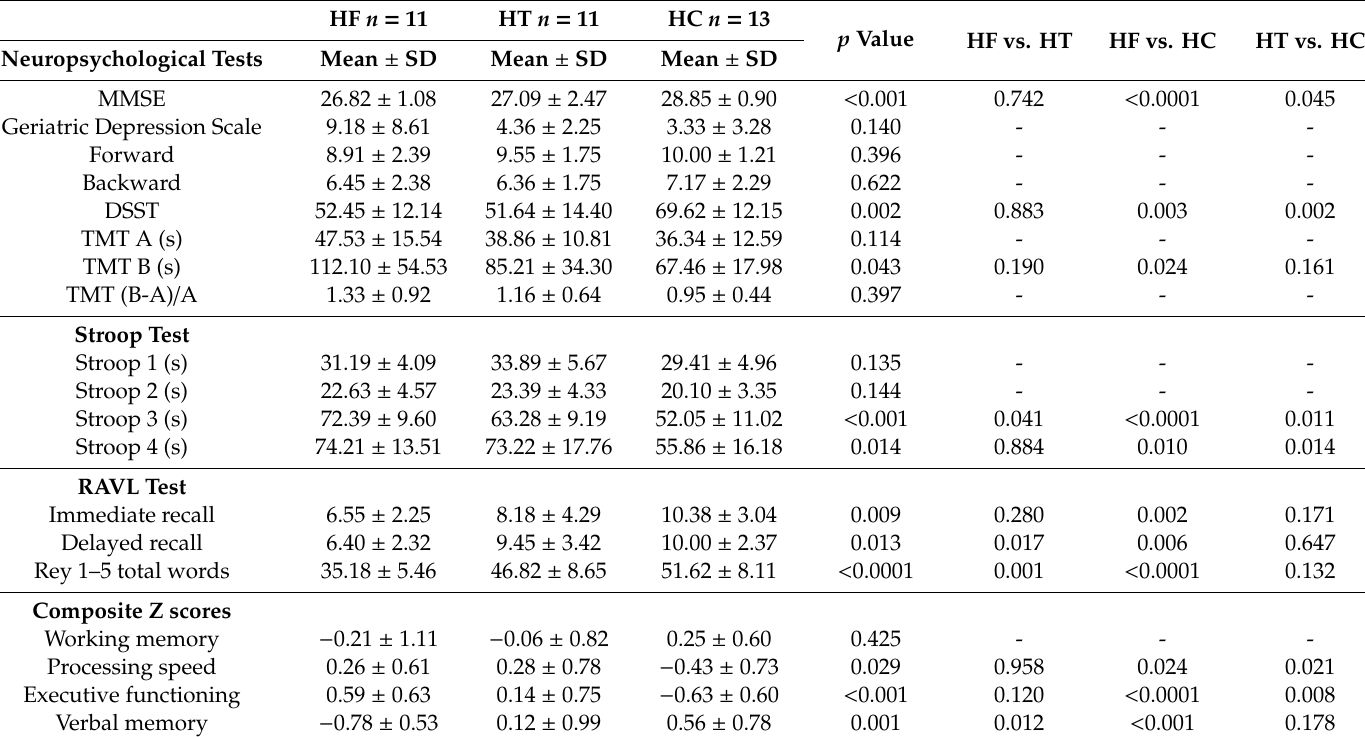
Table 3. Neuropsychological variables in HC, HF and HT